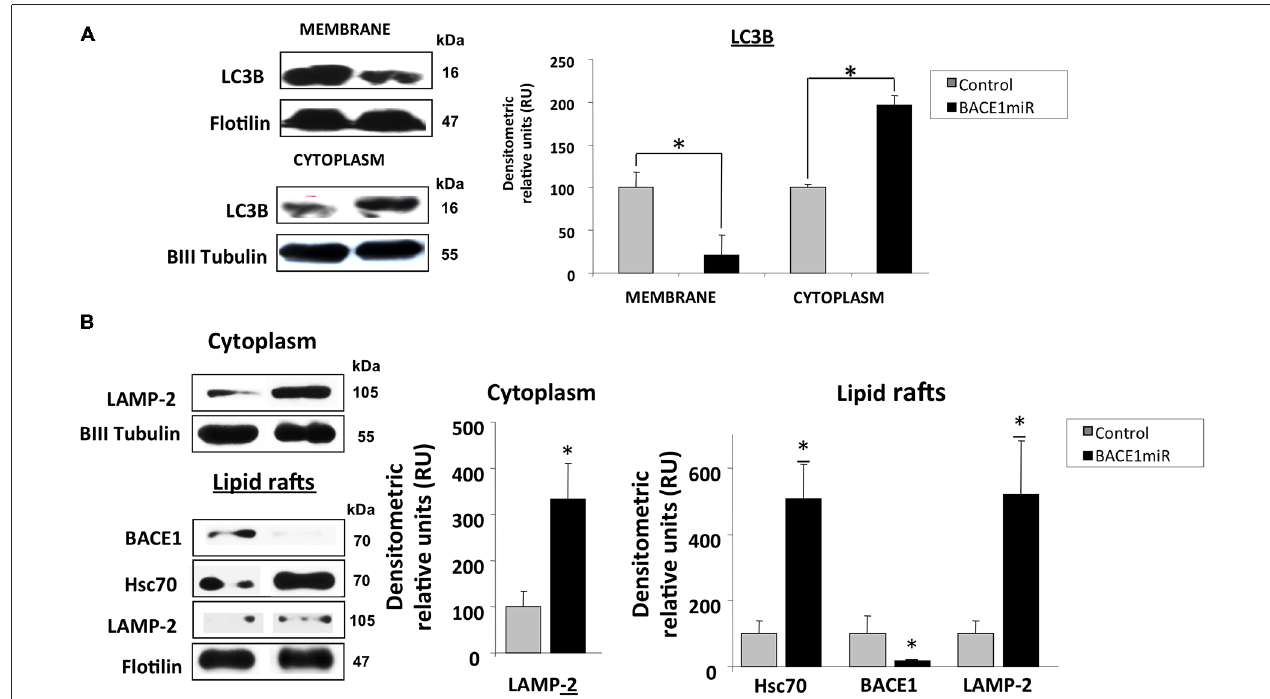
FIGURE 7 | BACE1 silencing upregulates Hsc70 and LAMP-2. Hippocampi of 15-month-old 3xTg-AD mice were analyzed at three weeks after injection with AAV2/5-BACE1miR (BACE1miR) or AAV2/5-GFP (GFP). (A) LC3-B protein levels in the membrane and cytoplasm fractions. (B) BACE1, Hsc70, and LAMP-2A protein levels in lipid rafts and LAMP2-A in the cytoplasm from hippocampi of 15-month-old 3xTg-AD mice treated for three weeks with AAV2/5-BACE1miR (BACE1miR) or AAV2/5-GFP (GFP). β III tubulin and flotillin were used as a loading control and a fraction control respectively Densitometric quantification was performed; RU = relative units. n = 4, ∗ p <